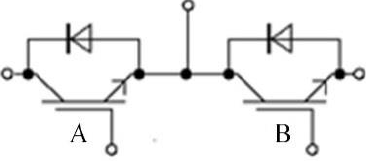
Figure 11. Diagram of the IGBT module principle.